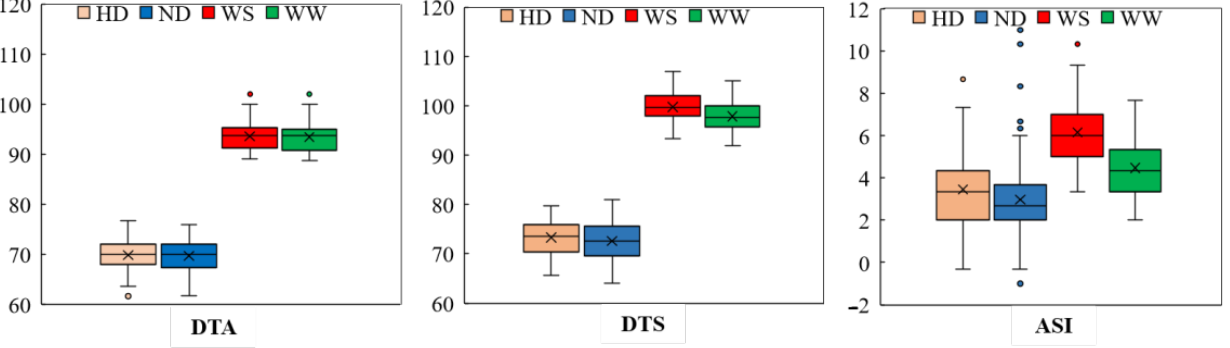
Figure 1. The boxplots of the phenotypic distribution of all of the 12-target trait-environment combinations between the three target traits, i.e., DTA (day); DTS (day); ASI (day) and the four evaluation conditions including well-water (WW); water-stress (WS); normal density (ND); and high density (HD).